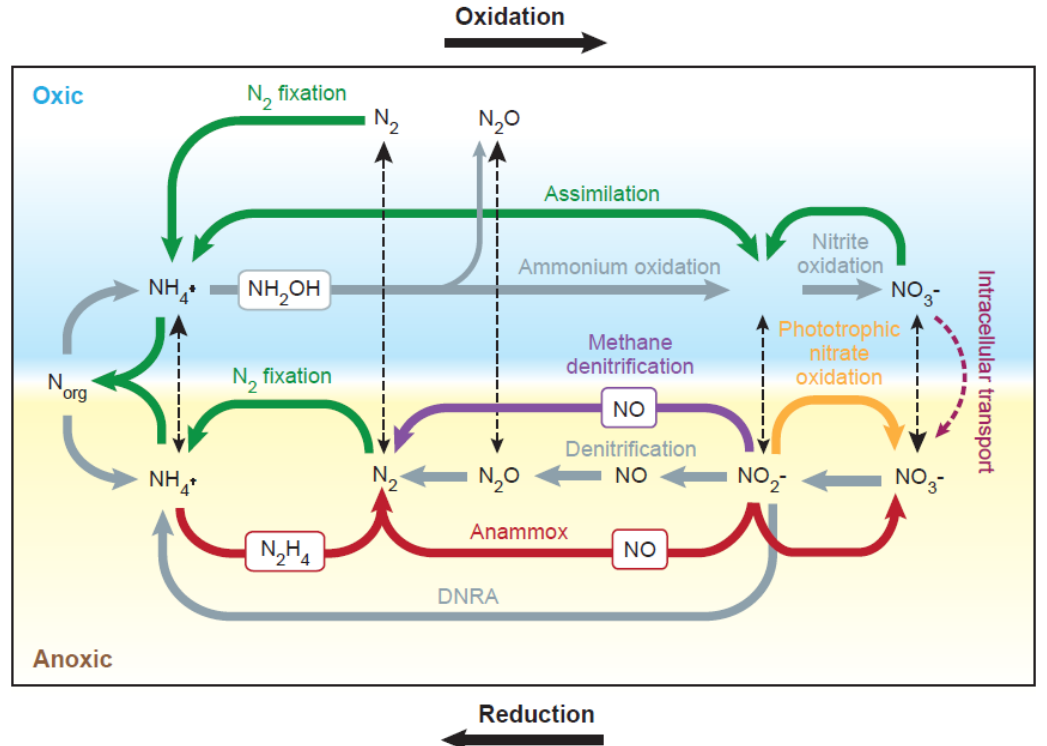
Figure 3. The nitrogen cycle showing all oxidizing and reducing transformation pathways that occur in oxidized and anoxic environments, particularly in marine sediments and waterlogged saline soils. Ammonification (shown in gray on left side) is the microbial breakdown of organic nitrogen (N ORG ) into ammonium (NH 4 + ); the reverse process is NH 4 + immobilization (green arrows on left). Nitrification (gray arrows in top side) is the biological oxidation of NH 4 + to NO 2 − followed by the oxidation of the NO 2 − to NO 3 − . Black dotted arrows depict transport processes between oxic and anoxic environments. Abbreviations: DNRA = dissimilatory nitrate reduction to ammonium; Anammox = anaerobic ammonium oxidation; N 2 fixation = nitrogen fixation; NO = nitric oxide; N 2 O = nitrous oxide; N 2 = nitrogen gas; NH 2 OH = hydroxylamine, an intermediate in biological nitrification; N 2 H 4 = hydrazine, the intermediate in the anaerobic oxidation of ammonium (anammox) process. Reproduced with permission from [121].